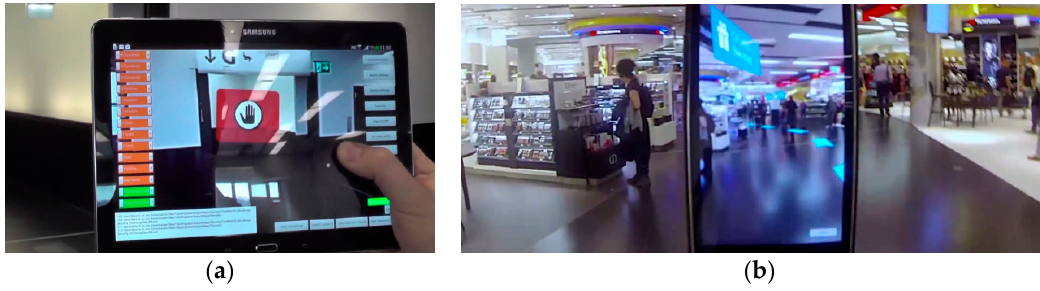
Figure 12. ( a ) The user was looking at the wrong passage indicated by the red sign; ( b ) Example of visualizing a path calculated especially for the user to find the way to the gate.